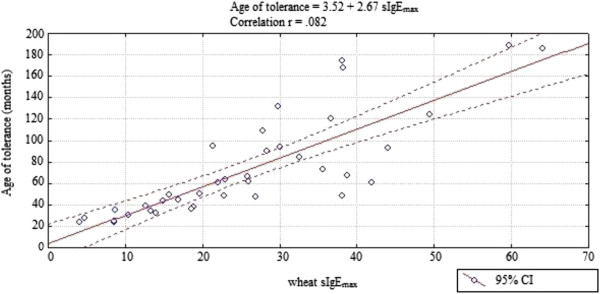
The curve of the correlation of the peak wheat sIgE level with the wheat tolerance development age.